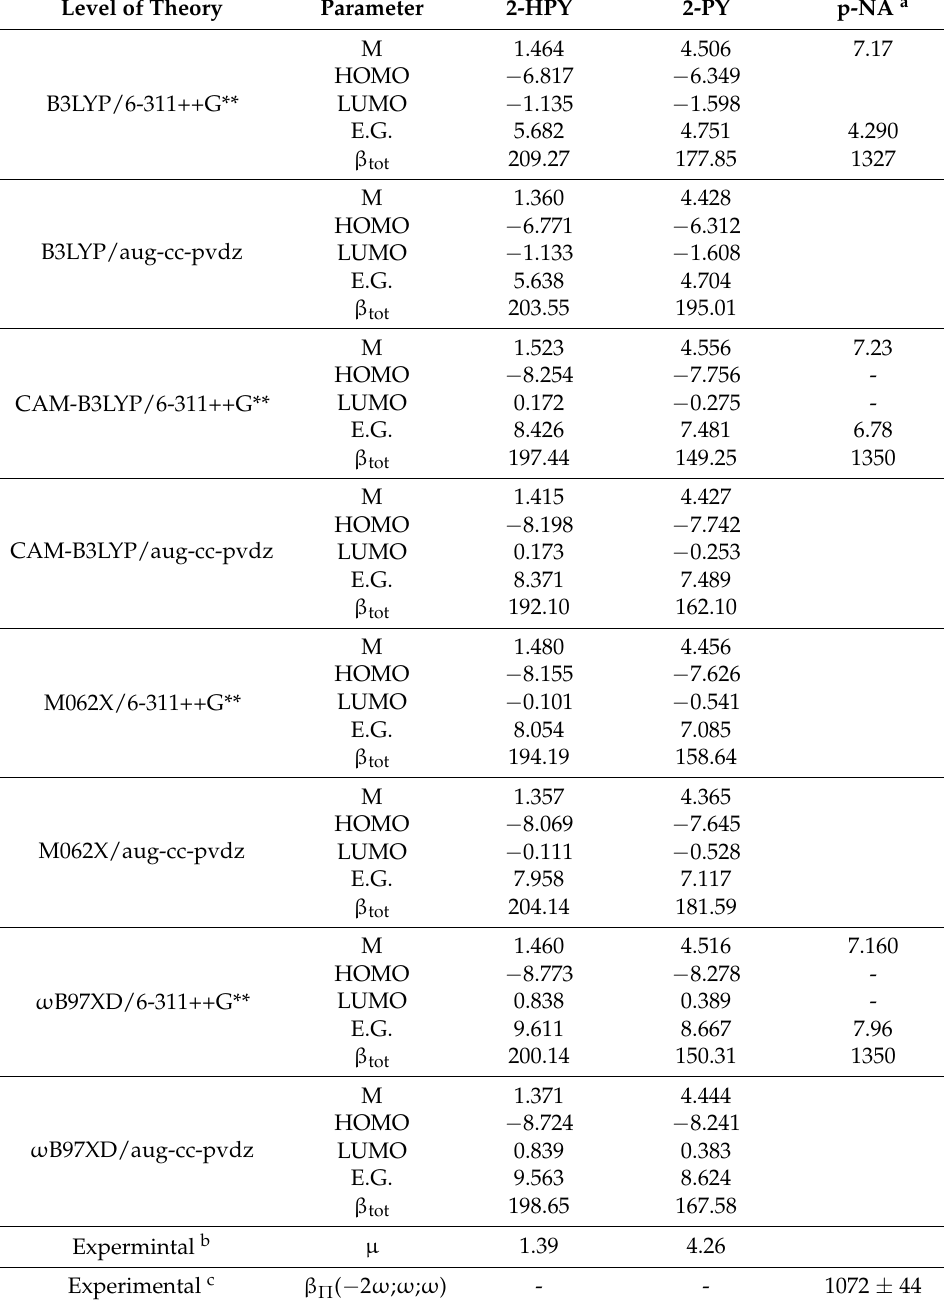
Table 7. The Dipole moments ( µ /Debye), HOMO and LUMO energies (eV) and their energy gaps (E.G. = ∆ E/eV), and the total hyperpolarizabilities ( β tot /a.u.) for 2-HPY and 2-PY which were estimated by utilizing B3LYP, CAM-B3LYP, M062X and ω B97XD functionals with 6-311++G** and aug-cc-pvdz basis sets. For comparison, the values for p-nitroaniline (p-NA) are